Question: What visual encoding does this figure use to show its data?
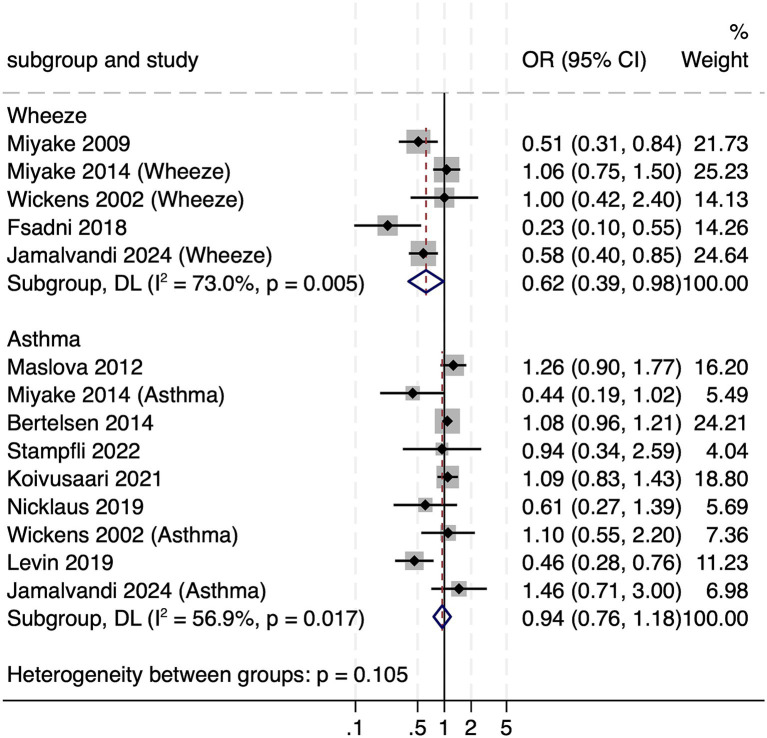
Answer: forest